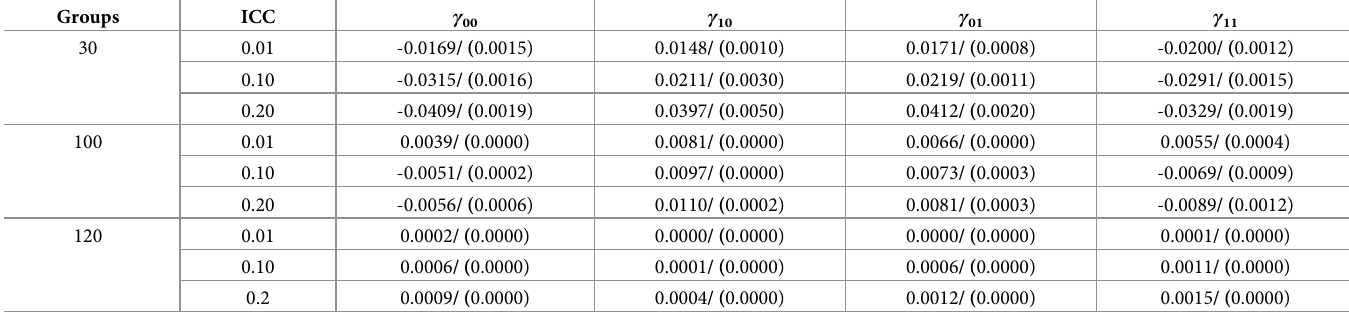
both fixed effects and random effects using HSB: 30 schools data set for the model in equation (1.8). The SAS package procedure PROC MIXED was used to obtain REML estimates and esti- mates standard errors. The REML confidence intervals were then constructed for each Table 4. Average relative parameter bias of fixed effect estimates obtained for lognormal distribution data (First = REML estimation procedure, Second = Bootstrap estimates are enclosed in parenthesis).